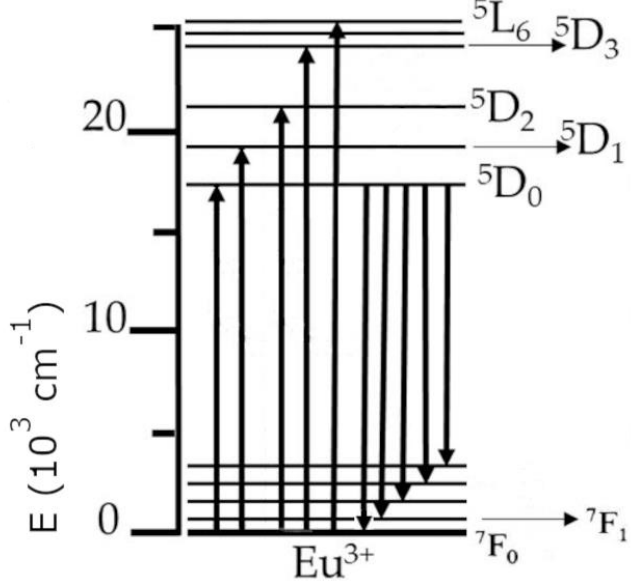
Figure 1. The partial energy diagram of the trivalent europium ion.